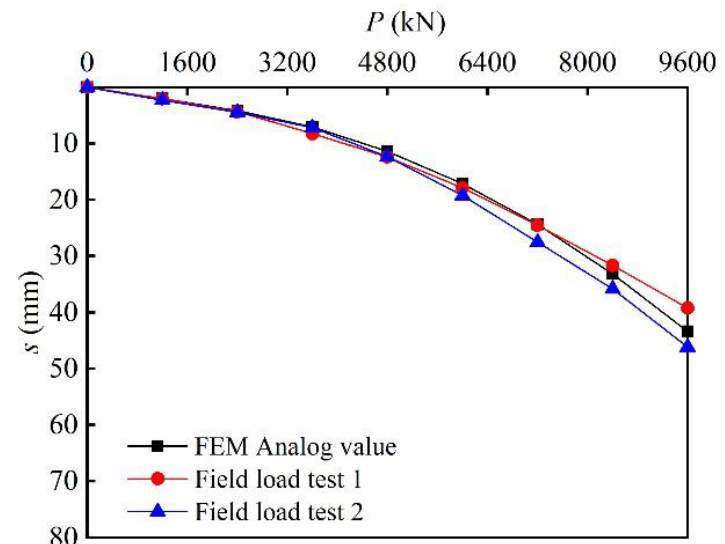
Figure 6. P - s curve .